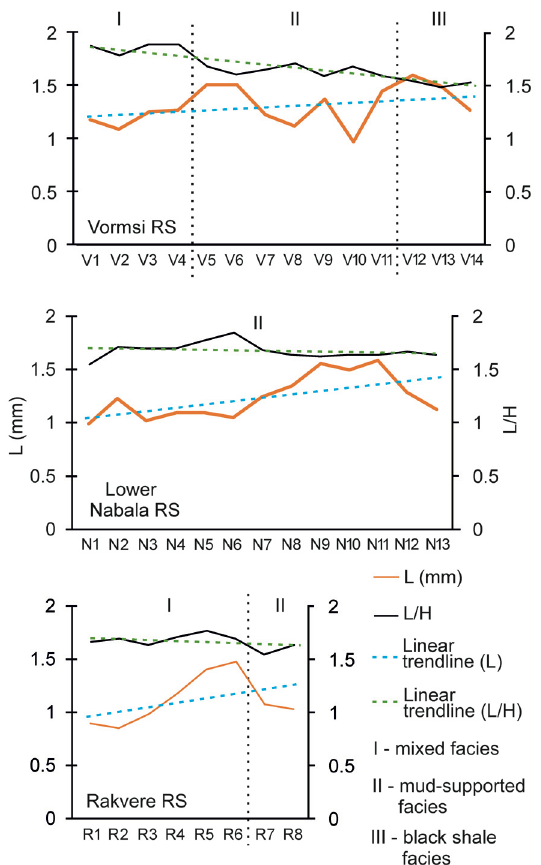
Fig. 11. Weighted arithmetic mean carapace size and shape in the analysed section intervals (specimen counts as weights).